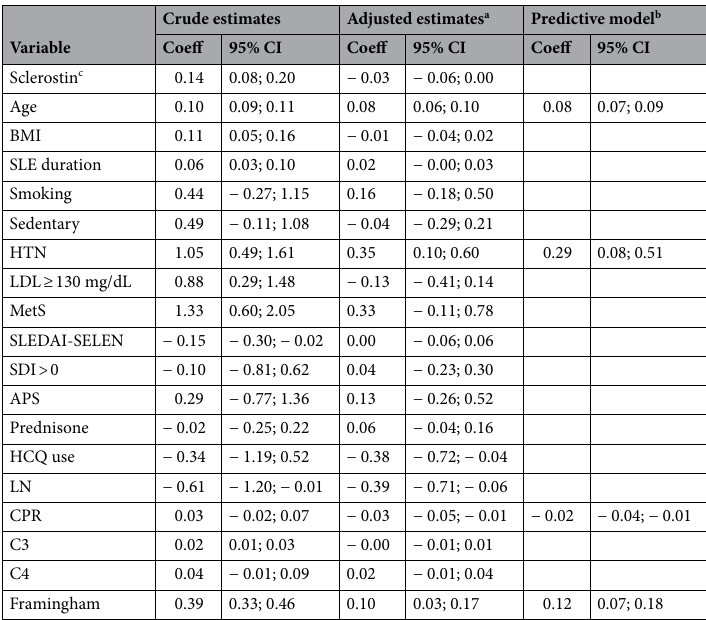
Table 3. Regression coefficients obtained through linear regression models for PWV values. BMI body mass index, HTN hypertension, LDL low density lipoprotein, MetS metabolic syndrome, SLEDAI-SELENA Systemic Lupus Erythematosus Disease Activity Index, SDI Systemic Lupus International Collaborating Clinics/American College of Rheumatology Damage Index, APS antiphospholipid syndrome, HCQ hydroxychloroquine, LN lupus nephritis. a The model included all the independent variables shown in the table. b The stepwise model included only variables with a p-to-enter value < 0.05 and a p-to-remove value > 0.10. c Estimated for sclerostin value ×